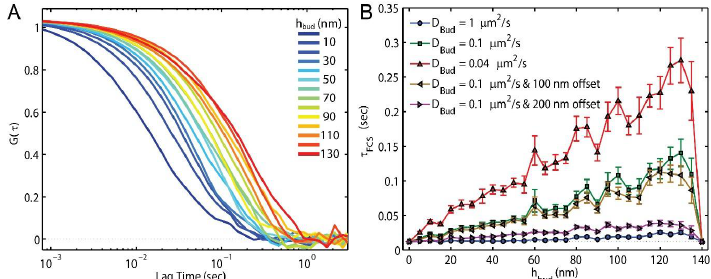
Figure 3. A membrane bud may be detected by fluorescence correlation spectroscopy (FCS) if h bud > 80 nm or the membrane curvature slowed the local lipid diffusion. While a lipid on the planar membrane experiences D Plane = 1 μm 2 /s, varying the diffusion rate of the lipid on the curved membrane and the location of the bud within the excitation spot affects the observed FCS results. ( A ) A shifting of G ( τ ) to longer lag times was apparent when D Bud = 0.1 μm 2 /s and the bud was centered on the 250 nm wide Gaussian illumination; ( B ) If D Bud = 1 μm 2 /s and h bud ≤ 50 nm, a minimal effect of the bud was observed on the measured τ FCS ; the extra membrane area and varying membrane orientation are not sufficient to affect the FCS results within the uncertainty of finding τ FCS . However, if D Bud = 0.1 μm 2 /s, the presence of the bud becomes clear for h bud ≥ 15 nm. The bud can be offset by 200 nm from the center of the illumination and still yield a clear change in the τ FCS . If the observation spot was off-centered from the bud by 100 nm or 200 nm, the effects of the bud are decreased by an average of 15% or 66%, respectively.